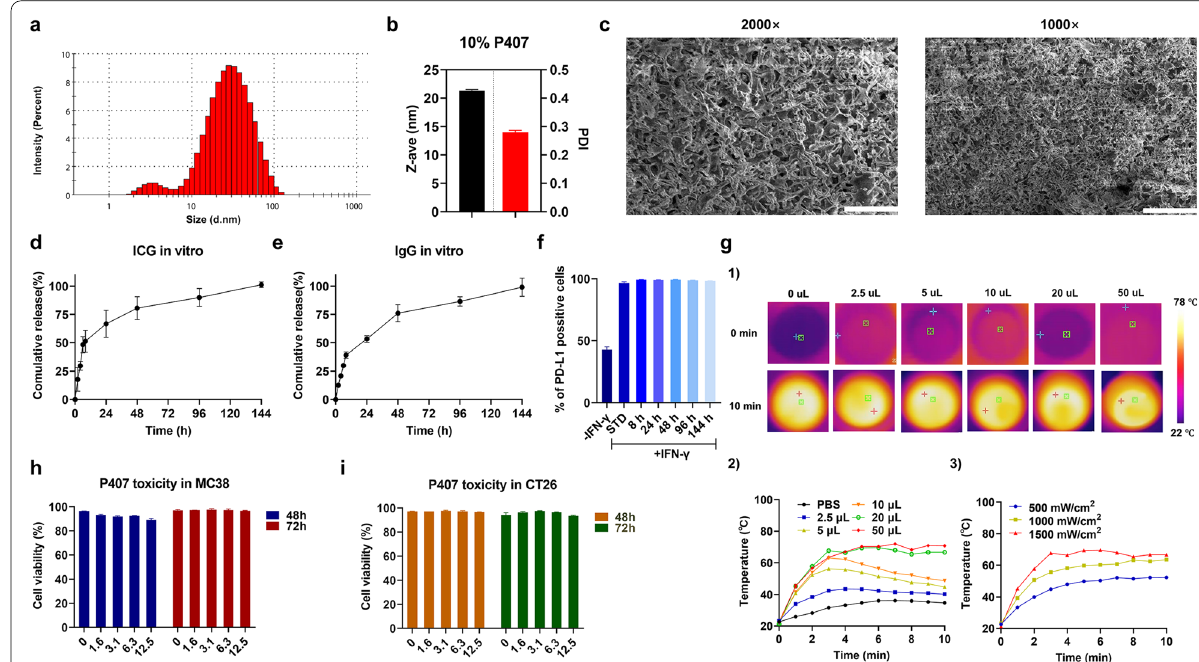
Fig. 6 Physicochemical and biological characteristics of the antibodies and ICG dual-loaded P407 hydrogel in vitro . ( a ) Representative histogram for the micelle size of the P407 hydrogel. ( b ) The z-ave and PDI of the P407 hydrogel. ( c ) Typical SEM images of freeze-dried dual-loaded 25% P407 hydrogel, 2000 (left panel, scale bar 20 µm) and 1000 (right panel, scale bar 40 µm) magnifications. ( d ) In vitro human IgG release from 25% × = × = P407 hydrogel. ( e ) In vitro ICG release from 25% P407 hydrogel. ( f ) Immune checkpoint antibody binding efficiency after release from 25% P407 hydrogel. ( g ) Photothermal effects of ICG-loaded P407 hydrogel. (1) Typical thermal images of ICG-loaded P407 hydrogel; temperature changes of ICG-loaded P407 hydrogel at different time points with (2) various volume samples and (3) various fluence rates. ( h ) Viability of MC38 cells and ( i ) CT26 cells, analyzed by means of 7-Amino-Actinomycin D (7-AAD) analysis with flow cytometry 48 h or 72 h after incubation with P407 hydrogel. All data show the mean values SEM from three independent ±